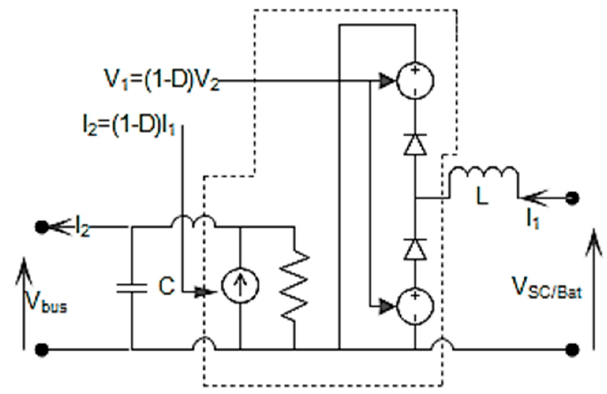
Figure 8. Average-value model of DC/DC converter.